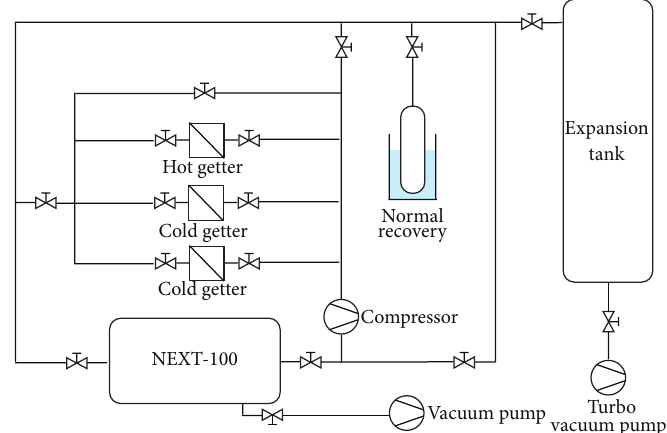
Figure 14: Scheme for the gas system of NEXT- 100 .